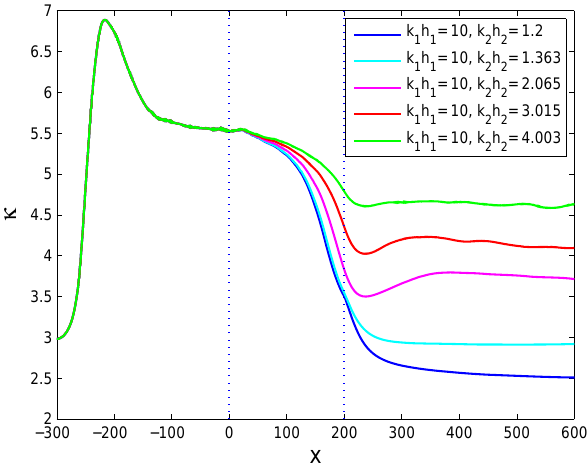
Fig. 4. Typical evolution of kurtosis on flat bottom for kh = 10.